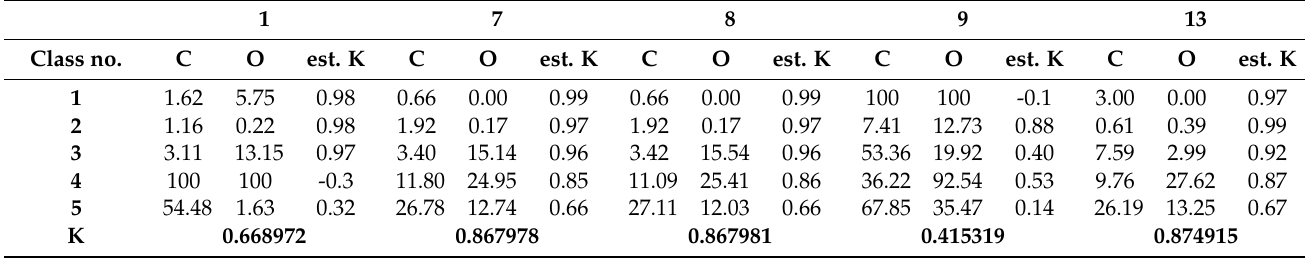
Table 5. The accuracy assessment for the Varaždin study area.